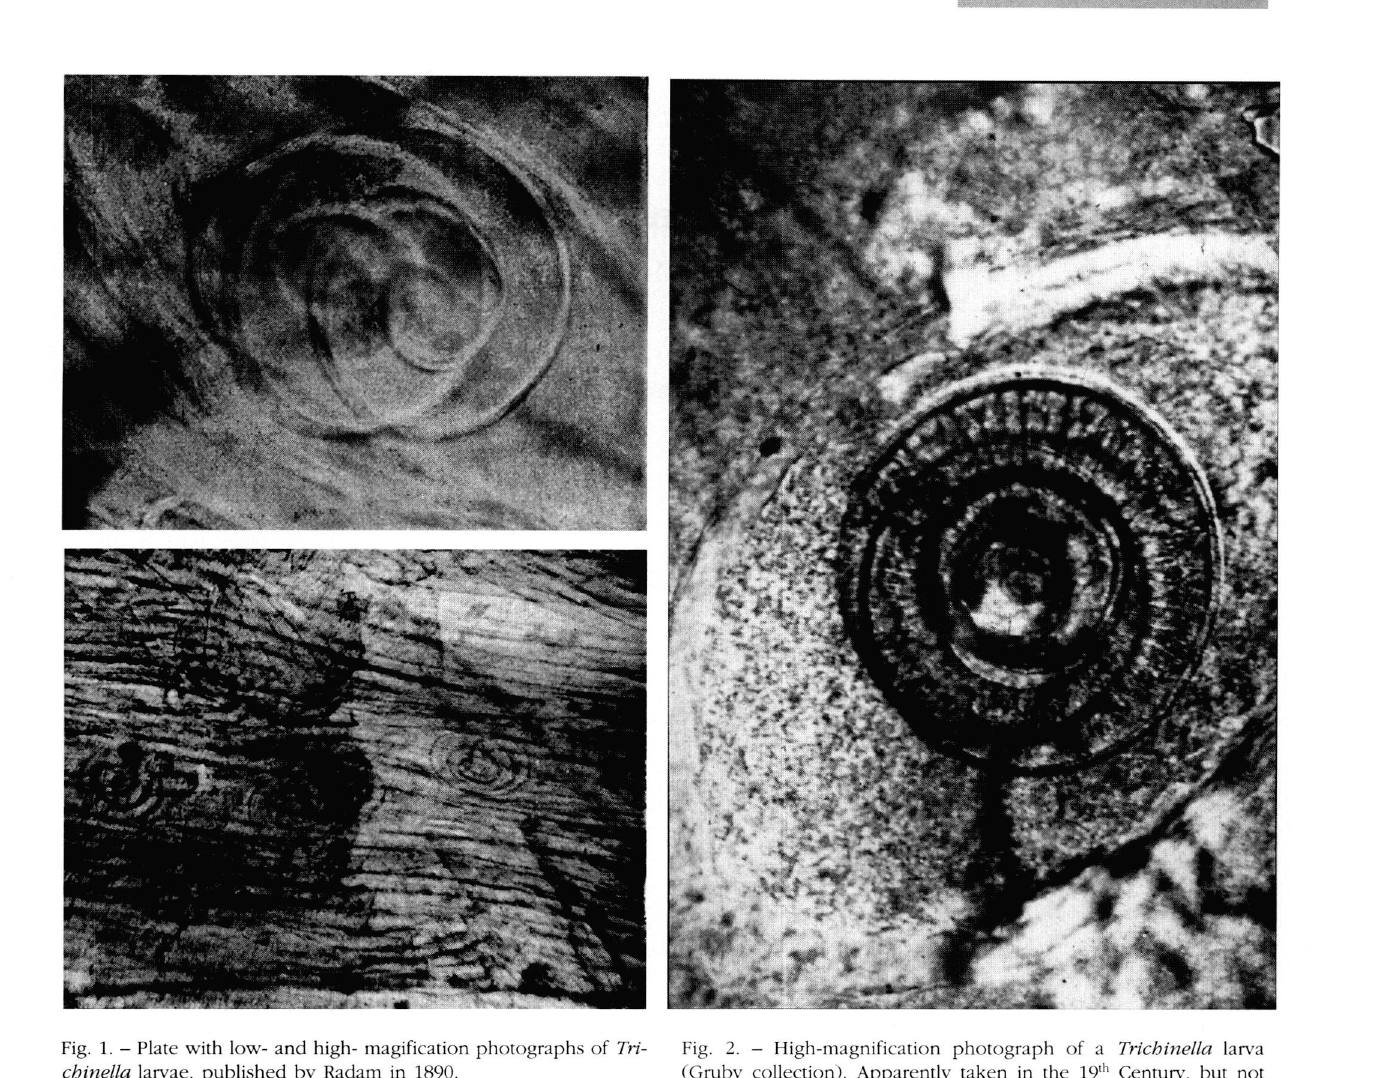
Fig. 1. - Plate with low- and high- magification photographs of Tri- chinella larvae, published by Radam in 1890.